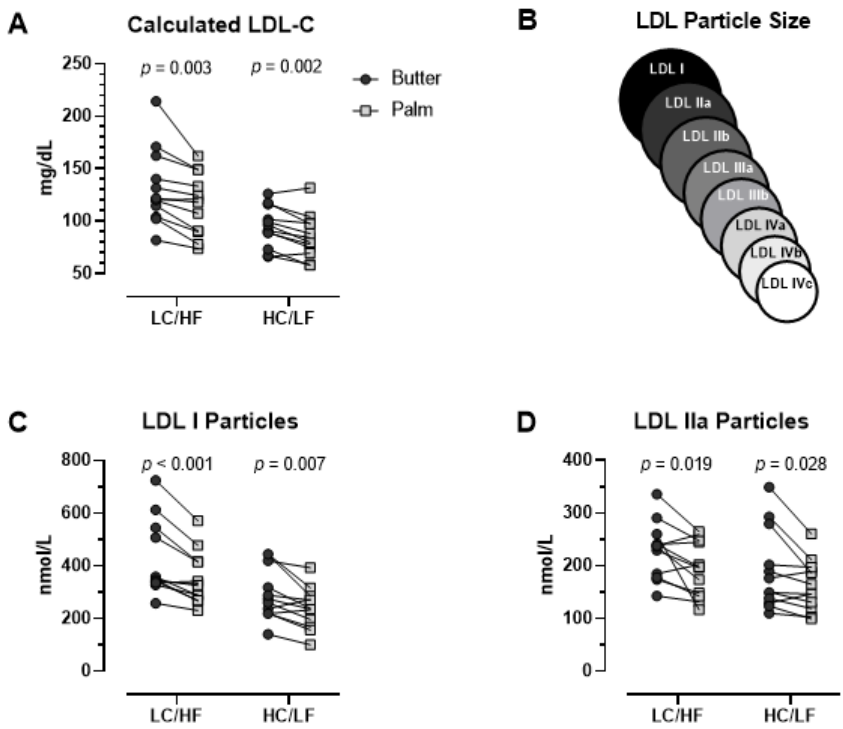
Figure 2. Individual fasting plasma low-density lipoprotein (LDL) responses between Butter and Palm Stearin diets in the low-carbohydrate/high-fat (LC/HF) and high-carbohydrate/low-fat (HC/LF) diet groups. ( A ) LDL-C (calculated), ( B ) LDL size schematic indicating LDL I and IIa as largest particles ( C ) LDL I (ion mobility), and ( D ) LDL IIa (ion mobility). p -values based on dependent t -tests.